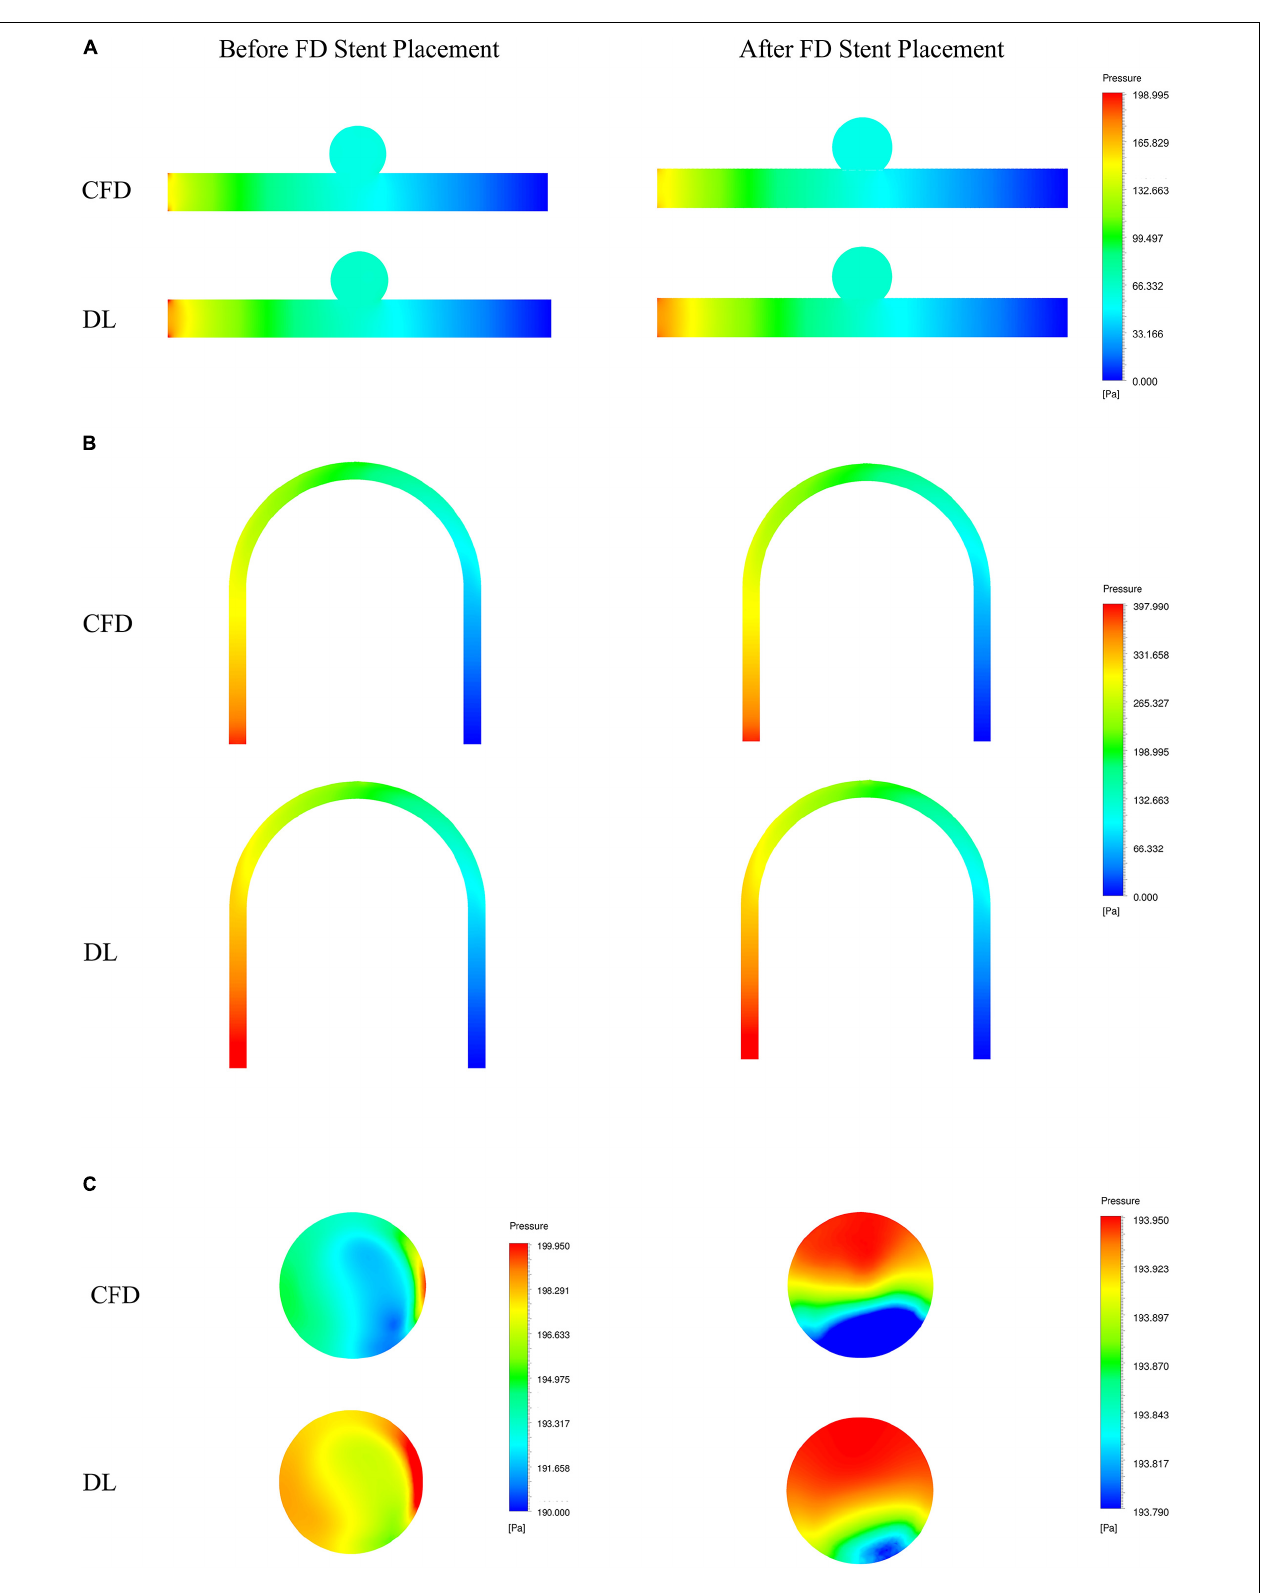
FIGURE 6 | Comparison of pressure fields from CFD and deep learning (DL) methods. (A) Type 1 model symmetry plane. (B) Type 2 model parent artery symmetry plane. (C) Type 2 model aneurysm cross section.